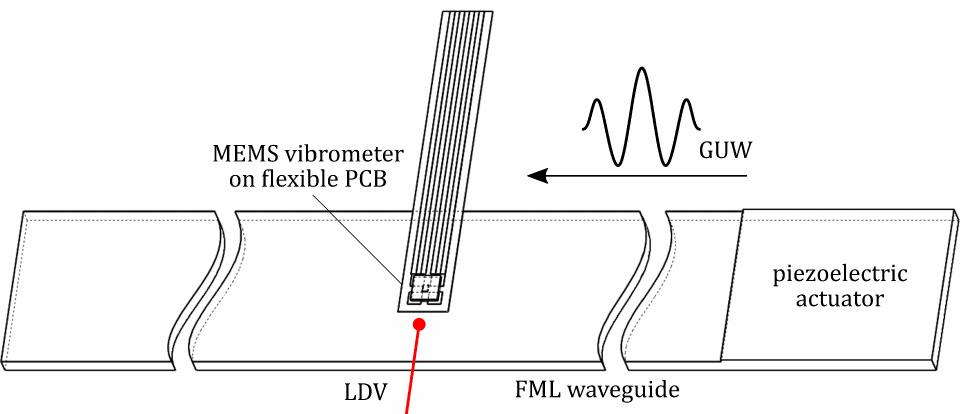
Figure 7. Test setup for GUW sensing experiments: FML waveguide with surface-bonded piezoce- ramic actuator, applied MEMS vibrometer, and reference LDV measurement at a distance of 0.2m from excitation.